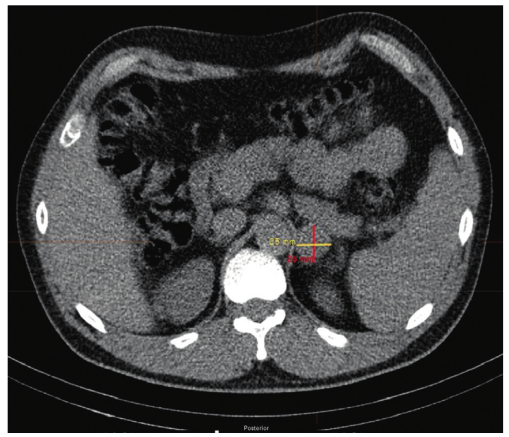
Figure 1: CT scan showing a 2.6 cm left adrenal